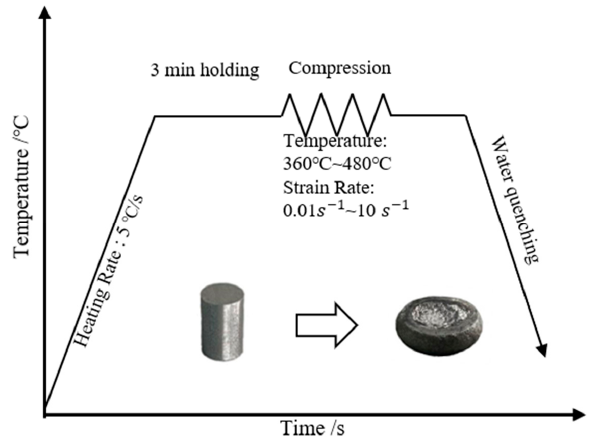
Figure 2. Hot compression